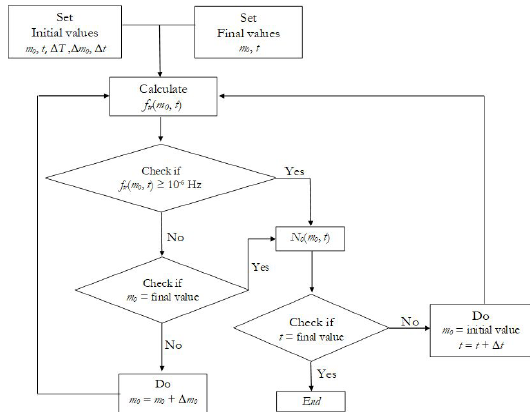
Figure 2. Workflow of the mathematic